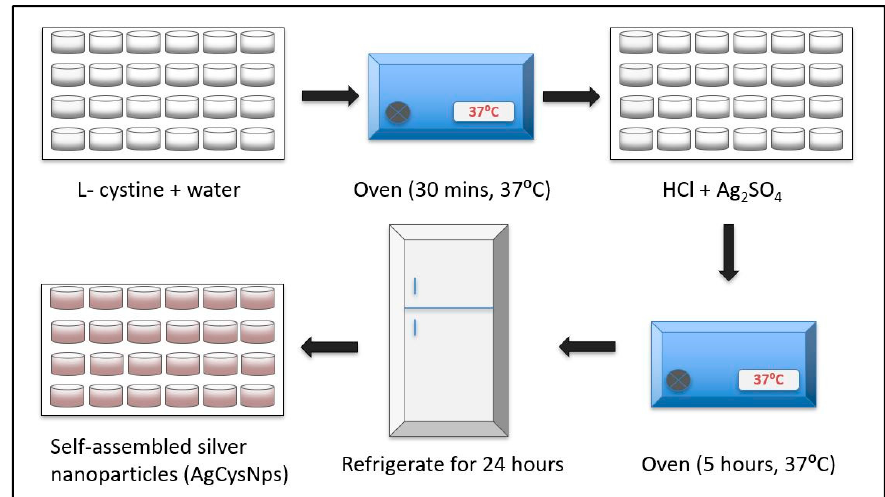
Figure 2. Schematic overview of synthesis of cystine-capped silver nanoparticles (AgCysNPs) MOBS. AgCysNPs were synthesized in microwell plates as indicated, and after completing the self-assembly step in refrigeration, were harvested, and dried for mass determination and use with in vitro testing as described in the methods .